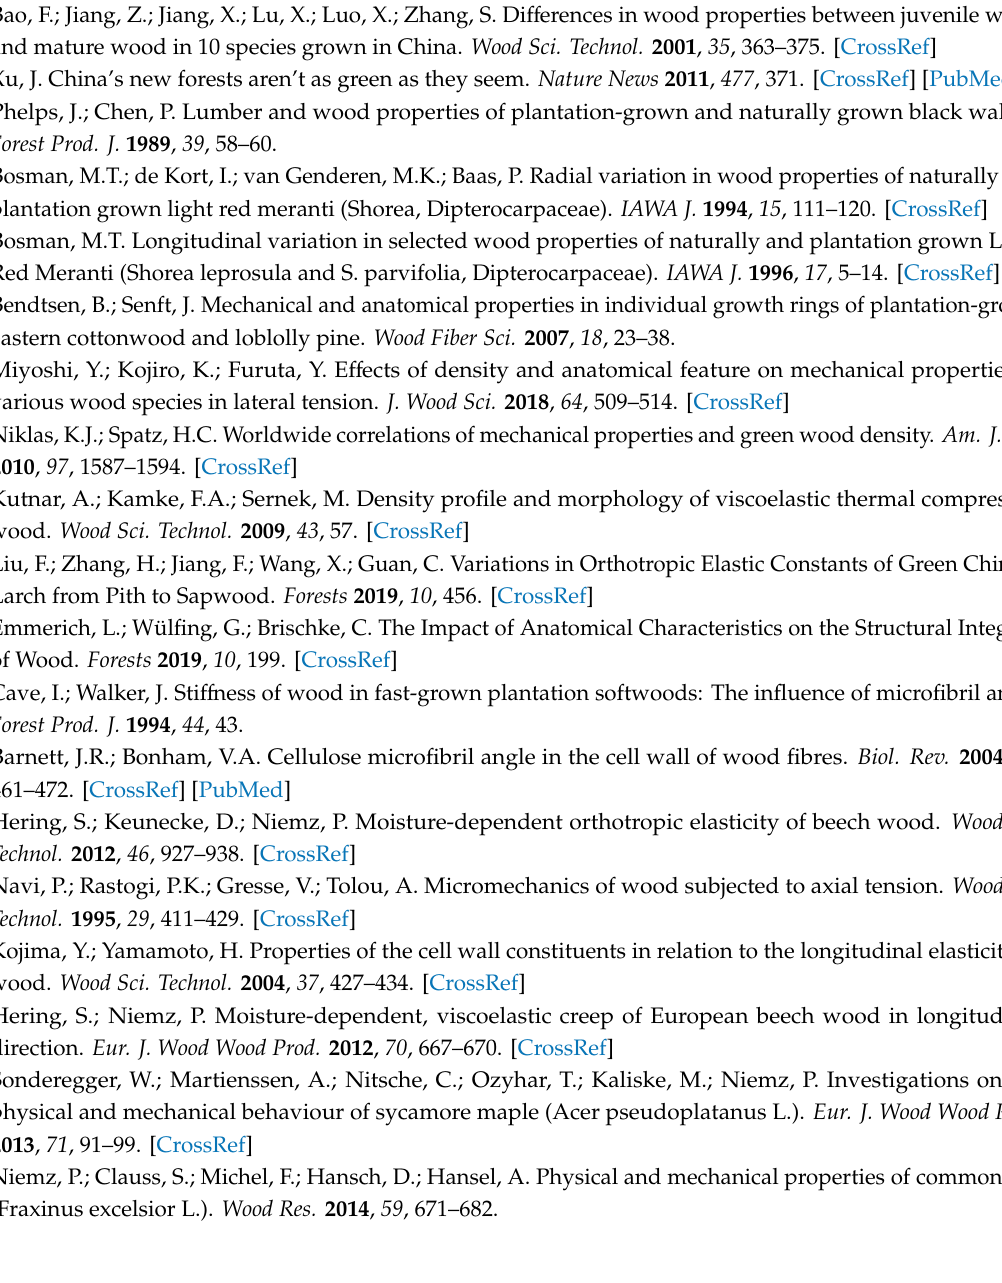
Figure S1: Schematic of L (a), R (b) or T (c) specimens, Table S1: Moisture content of poplar and Chinese fir, Table S2: Relative humidity-dependent sti ff ness of poplar and Chinese fir, Table S3: Relative humidity-dependent strength of poplar and Chinese